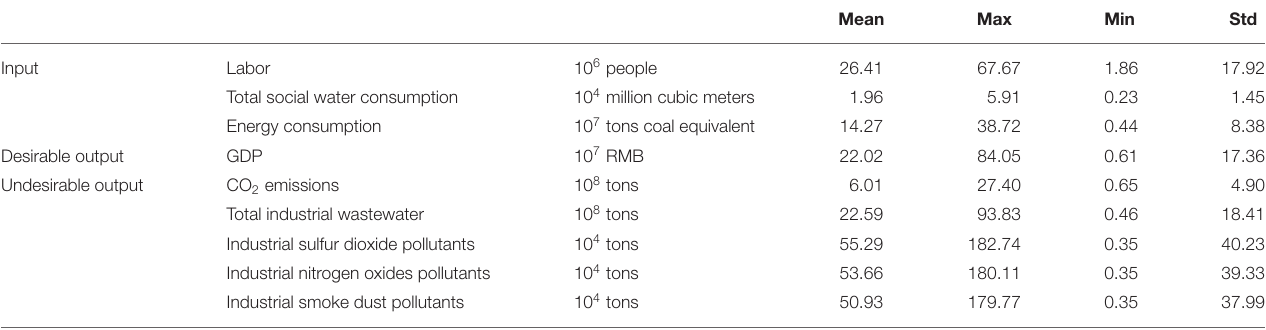
TABLE 1 | Statistical description of input and output variables.